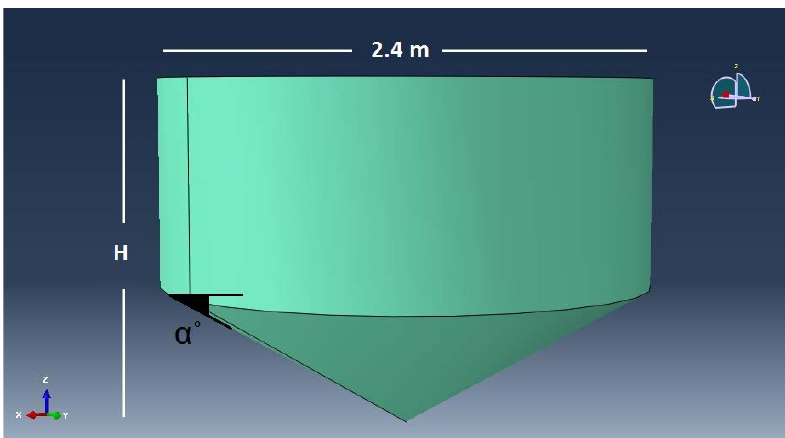
Fig. 6. Conical tamper and its variables used in numerical